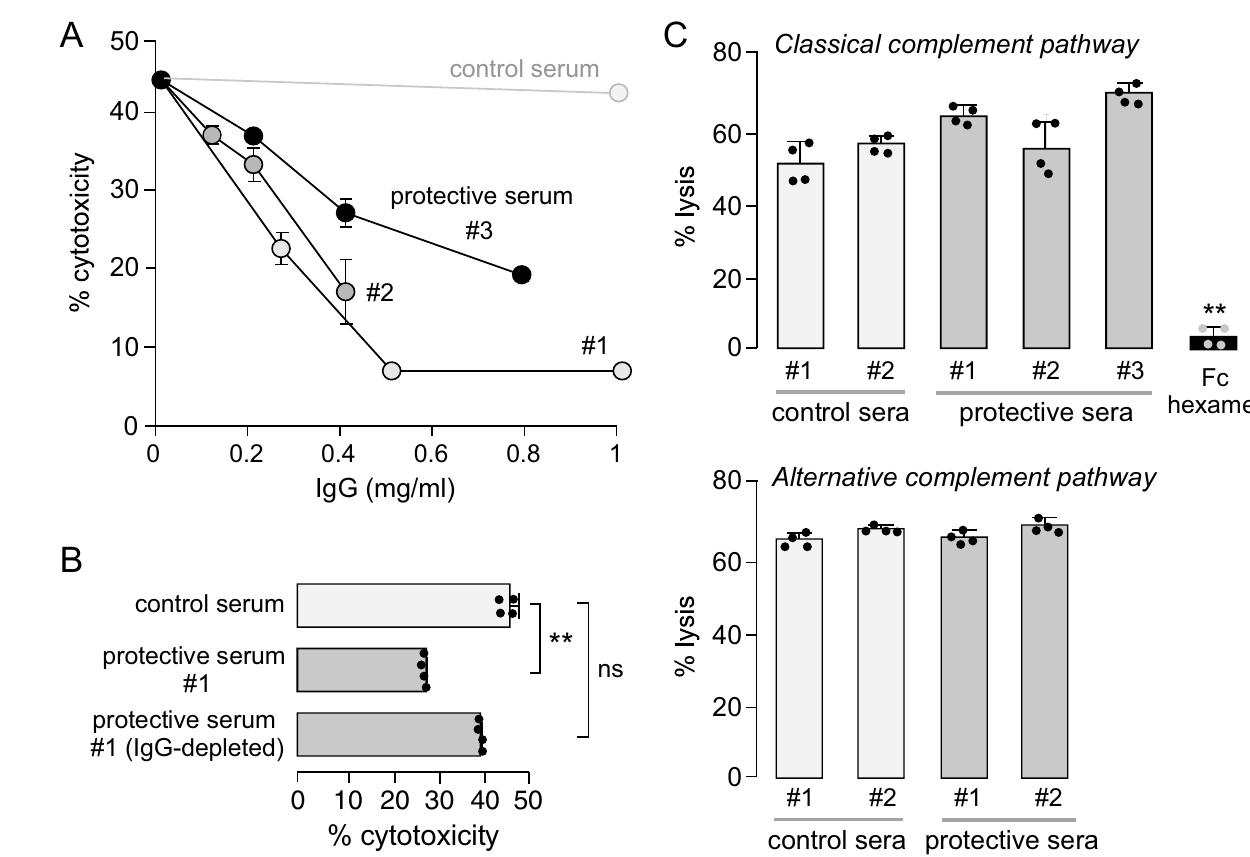
Figure 3. Cytoprotection is conferred by IgG antibodies and does not involve direct complement inhibition. ( A ) CDC measured in AQP4-expressing CHO cells, as in Fig. 2A, but using purified IgG isolated from NMOSD or control sera (mean ± S.D., n = 4). ( B ) CDC measured as in Fig. 2A, but using IgG-depleted cytoprotective NMOSD sera (mean ± S.D., n = 4, ** P < 0.01 vs. control serum, ns not significant, Kruskal–Wallis test with Dunn’s multiple comparison). ( C ) Activity of the classical (top) and alternative (bottom) complement pathways measured in erythrocyte lysis assays (mean ± S.D., n = 4, Kruskal–Wallis test with Dunn’s multiple comparison). Control or cytoprotective sera was present at 10% concentration. Differences not significant. Fc hexamer used as an inhibitor of the classical complement